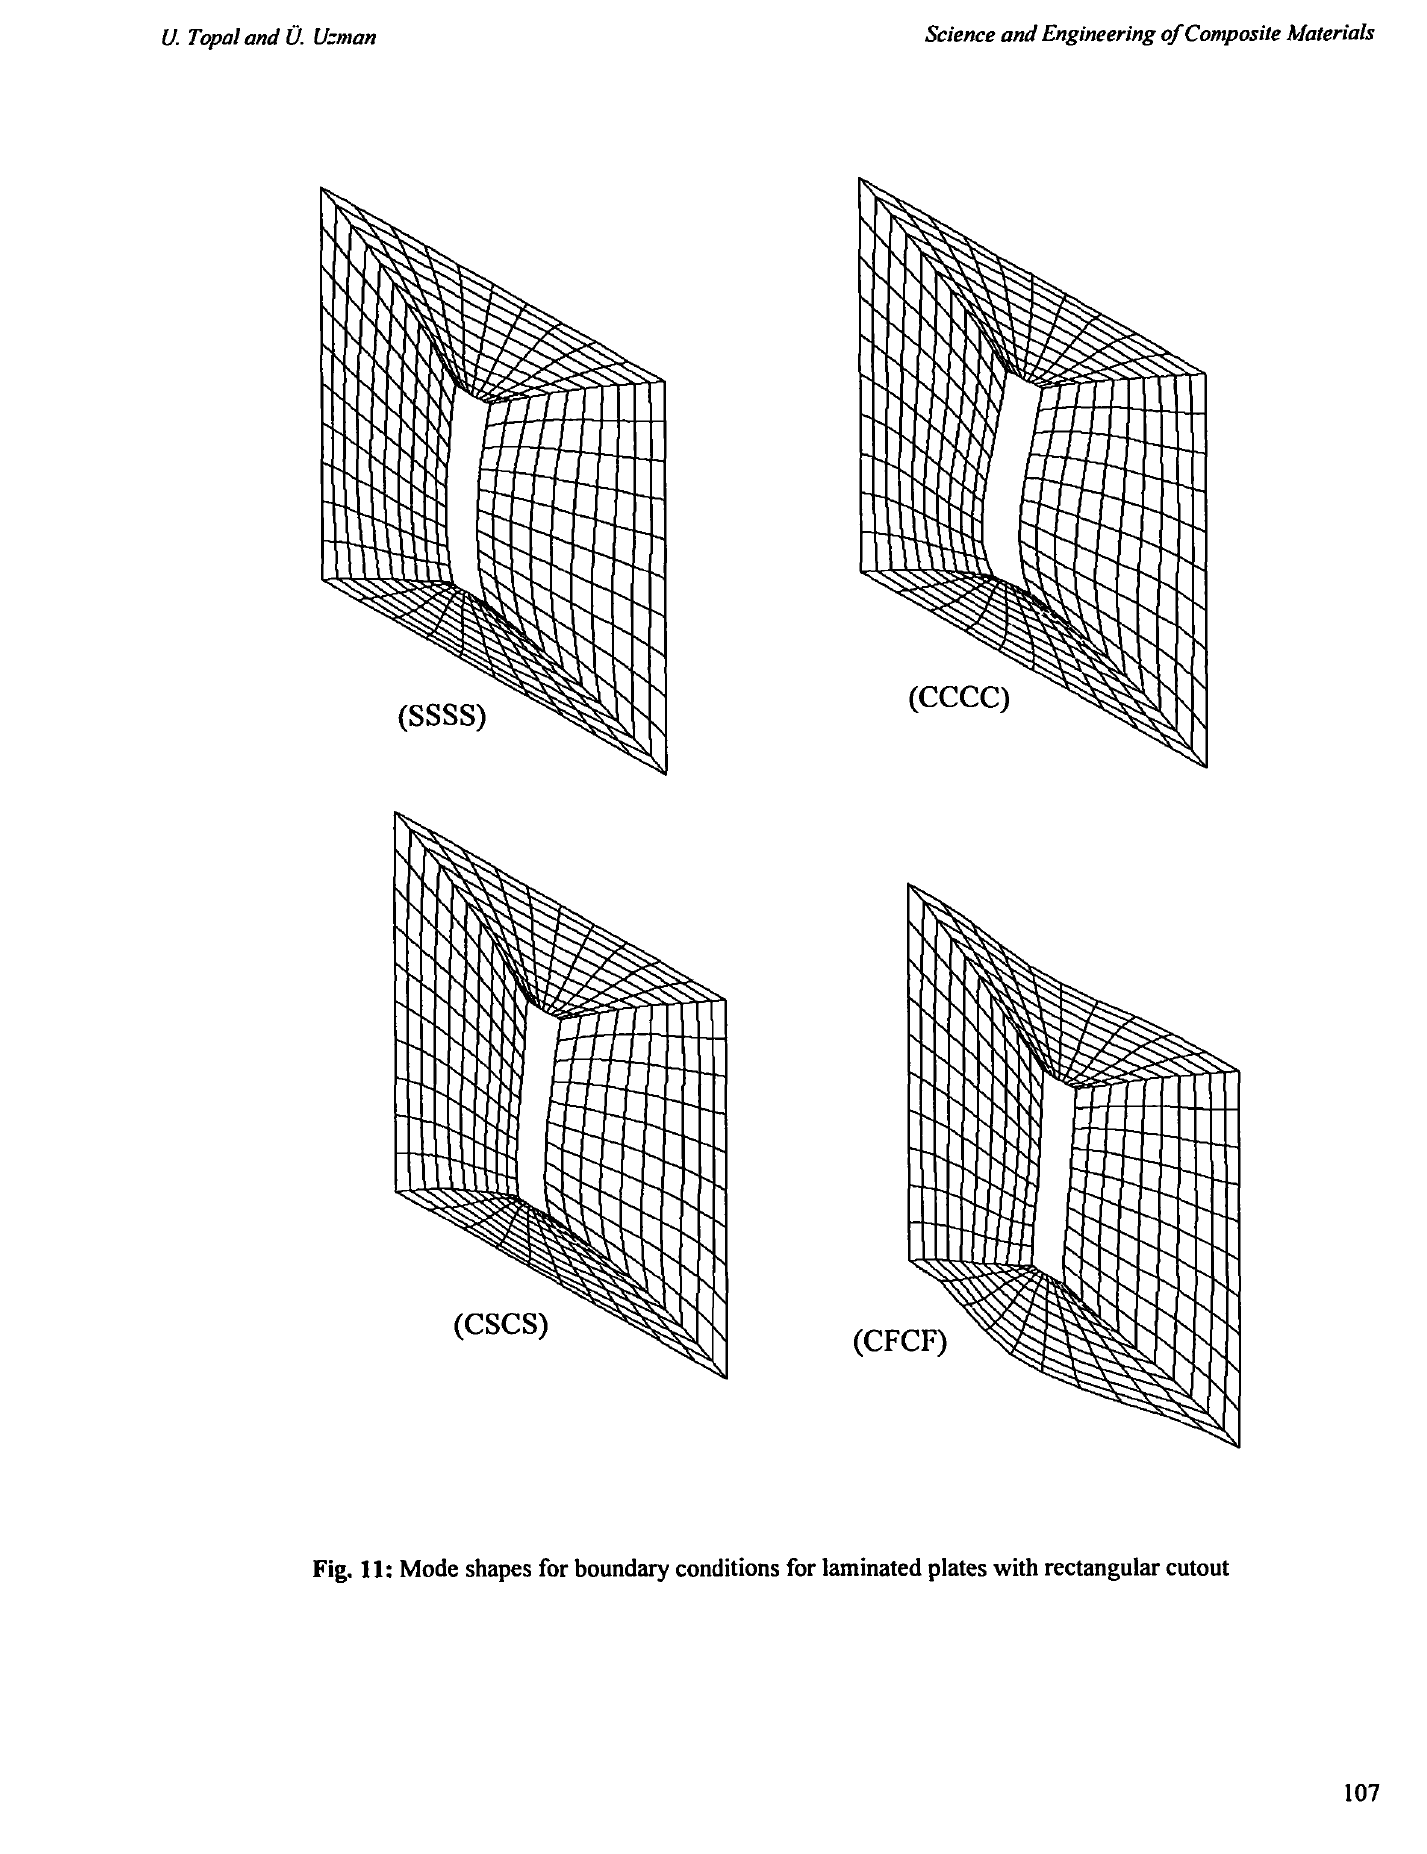
Fig. 11: Mode shapes for boundary conditions for laminated plates with rectangular cutout